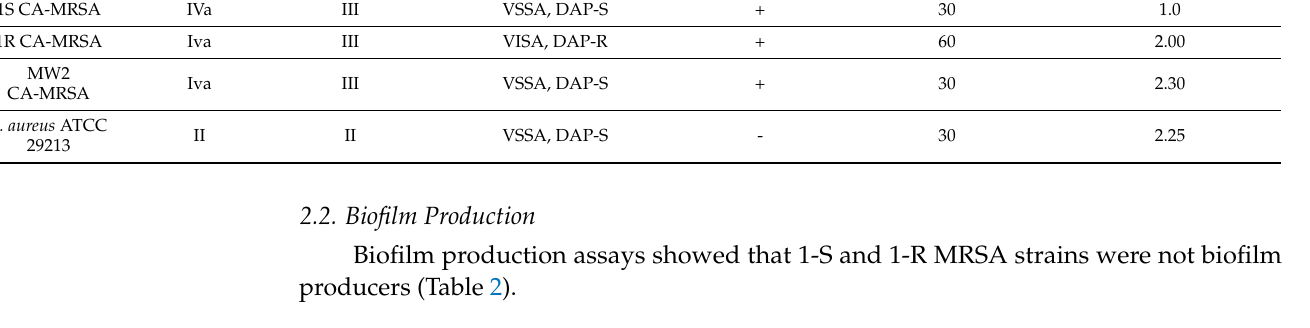
Table 2. Antimicrobial patterns, δ -hemolysis and biofilm production.